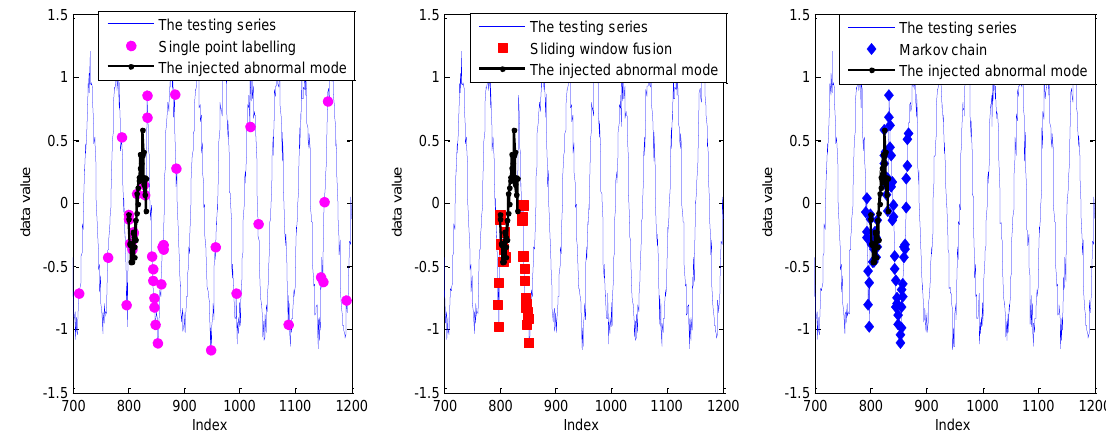
Figure 9. The detection results for the Keogh Data based on the RVM model with three labelling strategies under the sliding window size of 10.